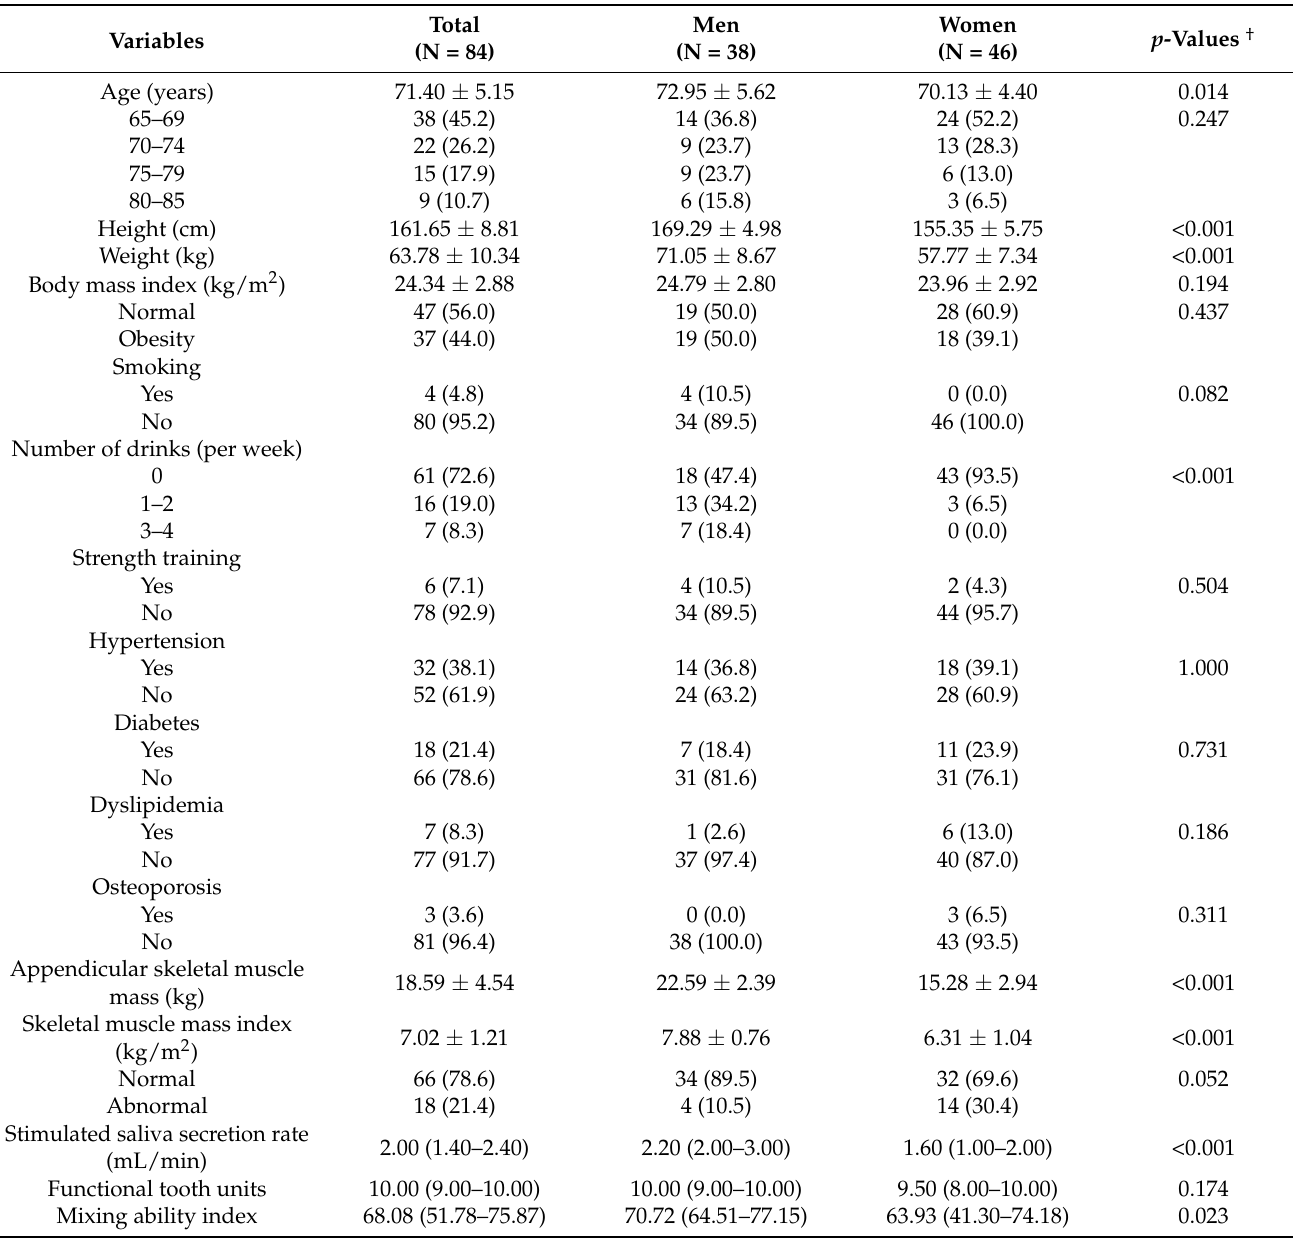
Table 1. Characteristics of the